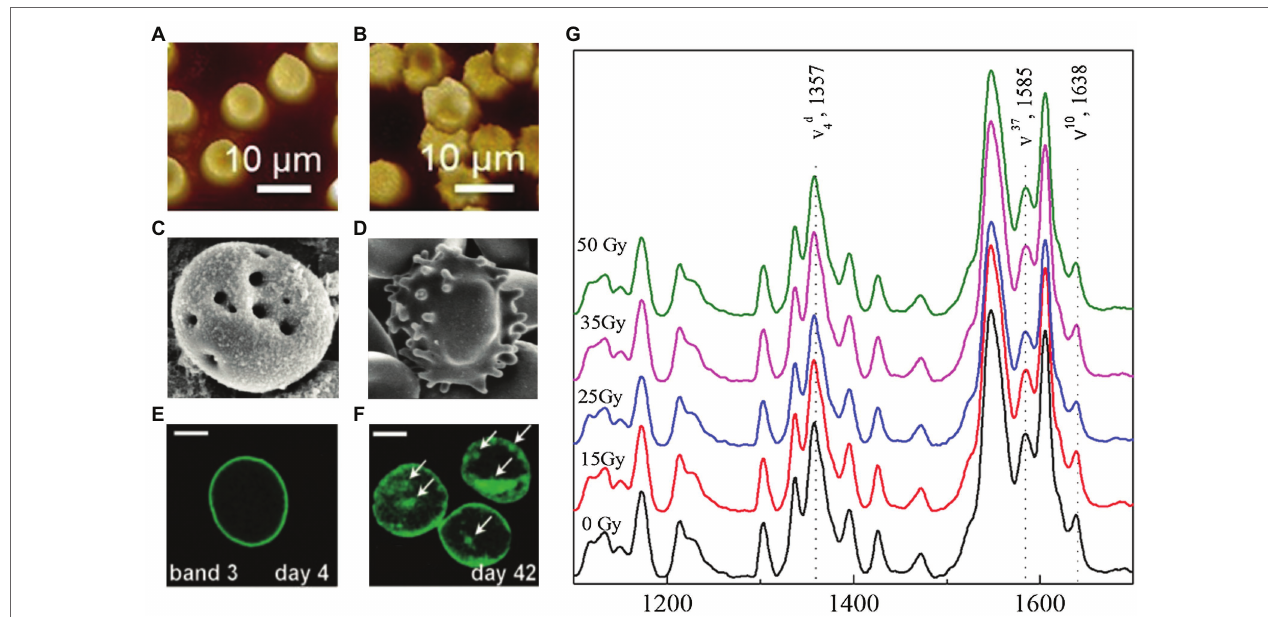
FIGURE 1 | Changes in red blood cells (RBCs) during storage and irradiation. Atomic force microscopy images showing the nanostructure of RBC membrane for (A) non-irradiated erythrocytes with homogeneous distribution in shape and size, and (B) irradiated erythrocytes with echinocytic morphologies and heterogeneous size distributions. The effects of storage revealed by scanning electron microscopy micrographs of erythrocytes stored after 28 days: (C) showing early signs of hemolysis and tiny pores in the membrane and (D) RBC with echinocytic morphology. The biochemical modifications induced by storage are visible in the fluorescence micrograph: (E) showing the band 3 distribution at day 4, and (F) the protein modifications associated with band 3 at day 42. The state of Hb’s oxygenation in RBC subjected to gamma radiation and stored can be tracked with Raman spectra. (G) Raman spectrum of Hb after 13 days of storage and at different doses of gamma radiation (15, 25, 35, and 50 Gy). In both cases, no appreciable changes related to oxygen in the heme group configuration are detected. Figures were modified from (A-B) Santacruz-Gomez et al. (2016), (C-D) Mustafa et al. (2016), (E-F) Antonelou et al. (2010), and (G) Acosta-Elías et al.